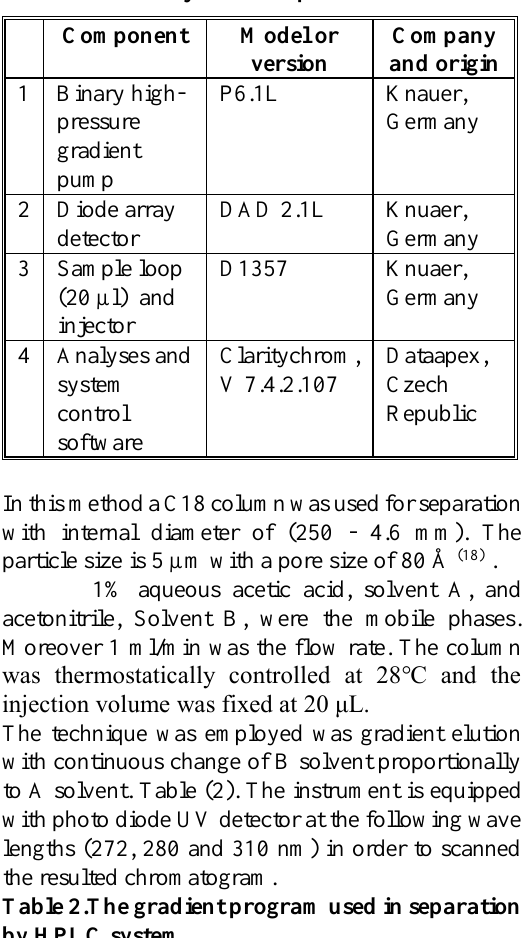
Table 1. HPLC System components .